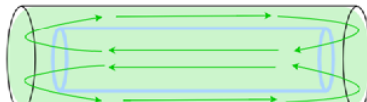
Figure 7. BBMSR with U-Tube blanket (8 regions).